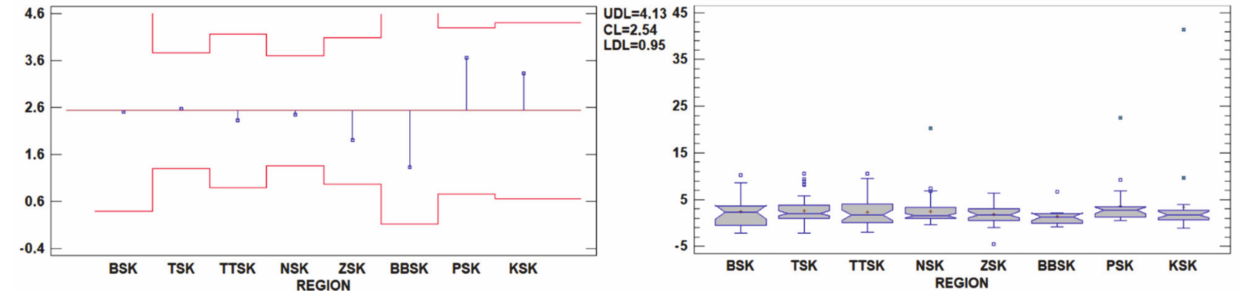
Figure 2. Comparison of the structure of the results by region at the level of individual regions—Altman model, agricultural cooperatives. Legend: BSK—Bratislava region, TSK—Trnava region, TTSK—Trenˇc í n region, NSK—Nitra region, ZSK— Žilina region, BBSK—Bansk á Bystrica region, PSK—Prešov region, KSK—Košice region; UDL—upper decision limit, CL—central line, LDL—lower decision